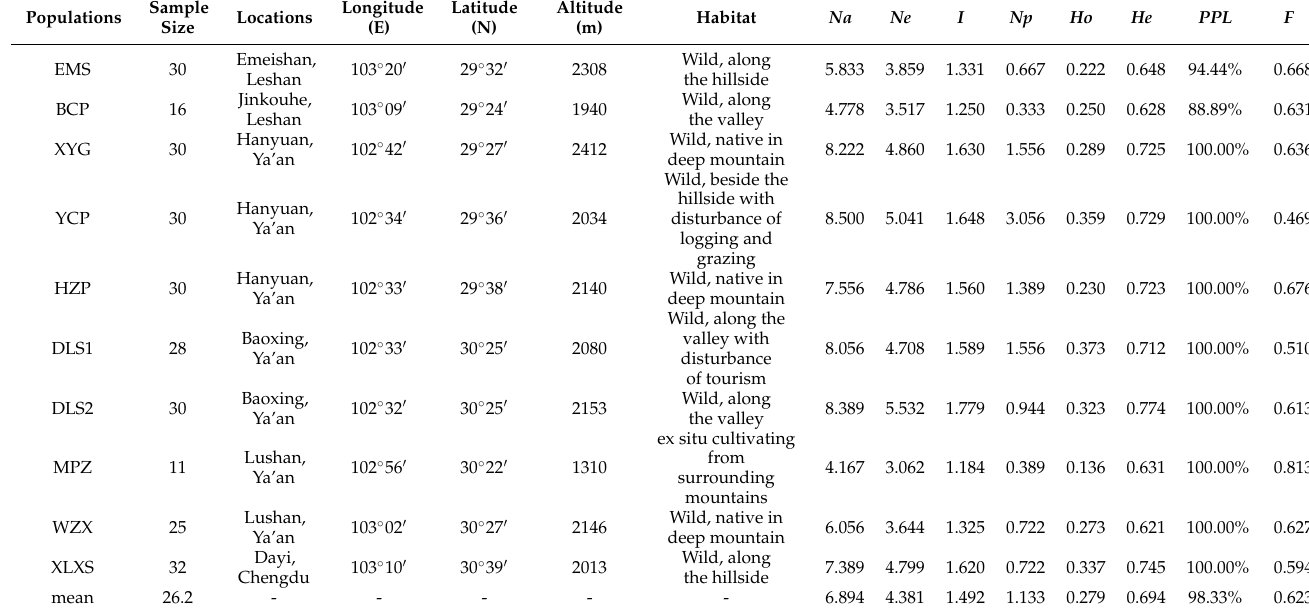
Table 1. Geographical location and genetic diversity for ten O. serrulatus populations in southwestern Sichuan Basin, China. Populations Sample